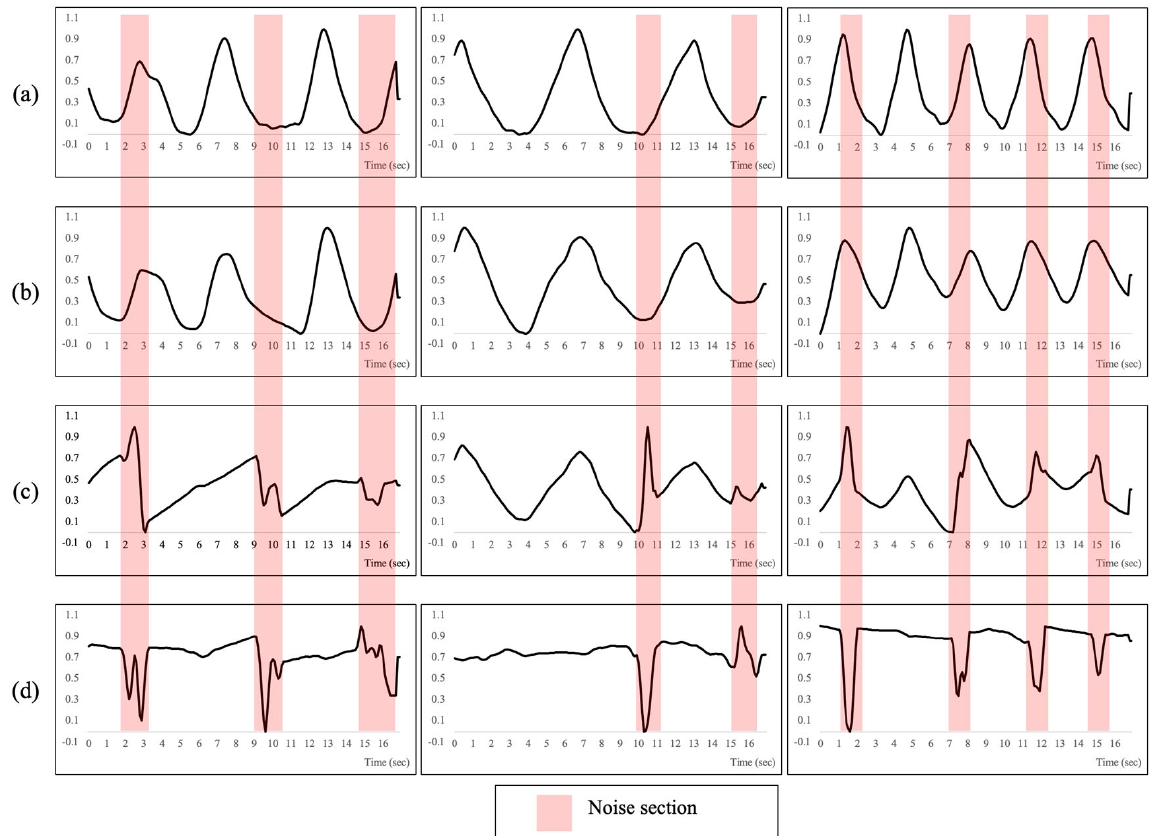
Figure 14. Examples of references and estimated signals on motion noise environment: ( a ) reference, ( b ) ours, ( c ) optical flow-based, and ( d ) intensity-based.